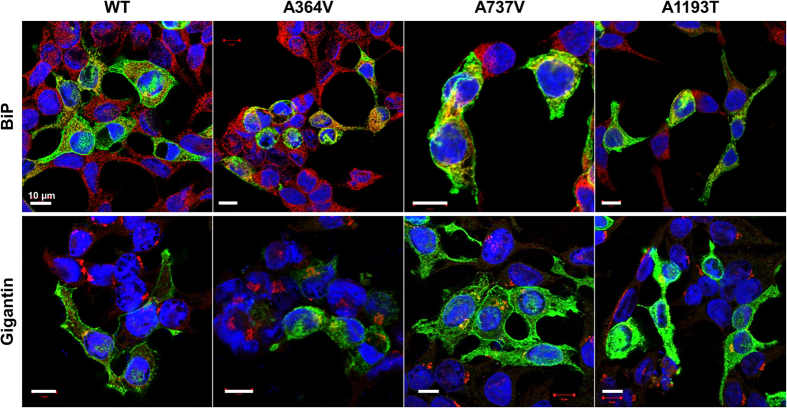
Effect of ABCB4 mutants on subcellular localization.HEK-293T cells were transfected with ABCB4 wild type or mutant plasmids. Cells were fixed and permeabilized with methanol, and immunostained with anti-MDR3, and an endoplasmic reticulum maker BiP or a Golgi marker Gigantin antibodies. Scale bars, 10 μm.